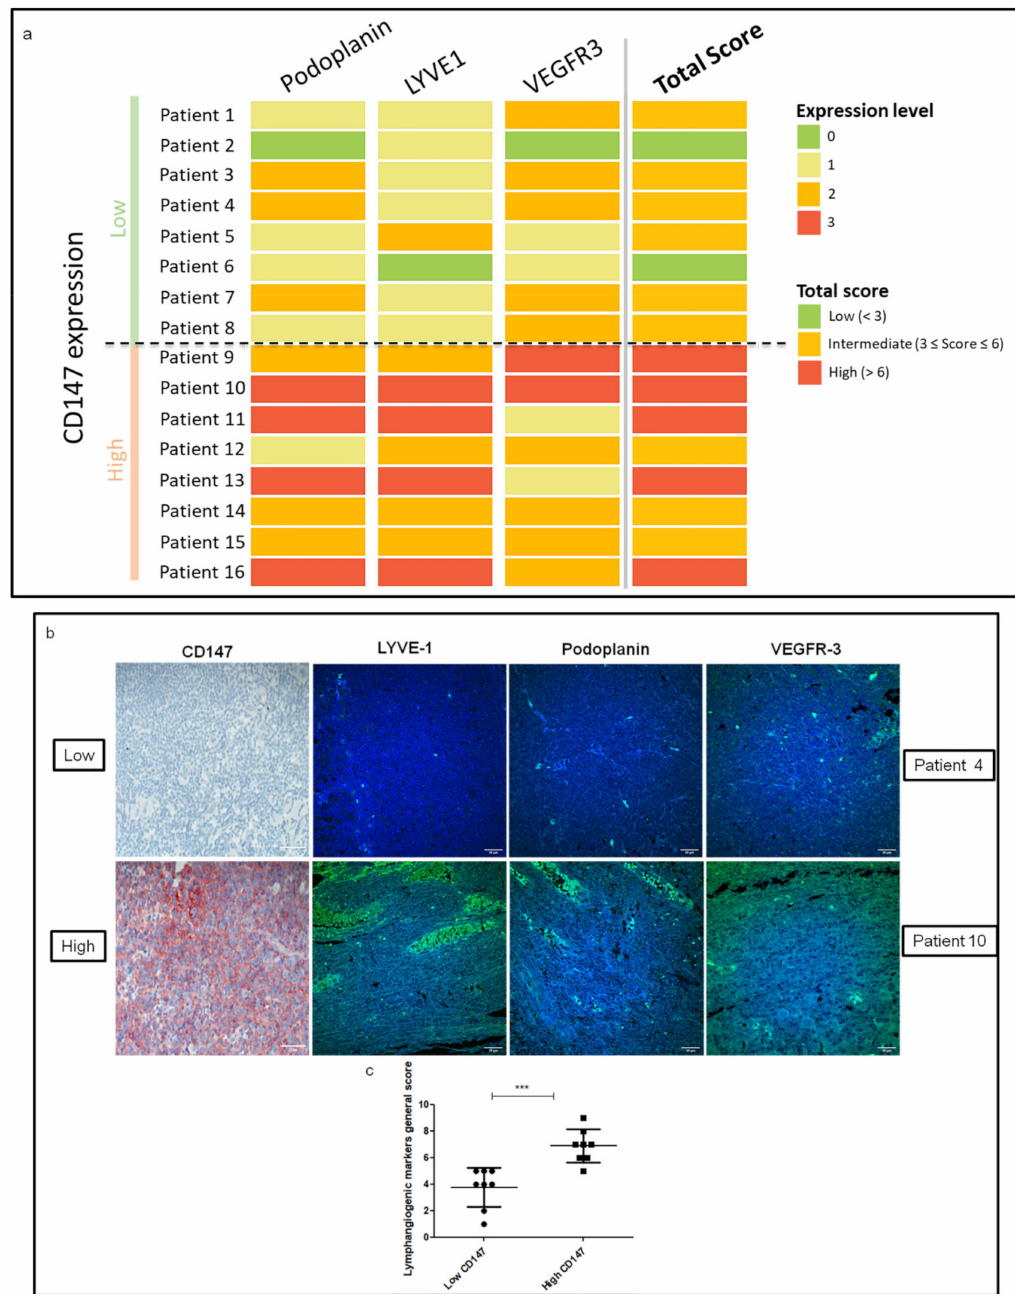
Figure 1. Lymphangiogenic markers’ expression in human melanoma lymph nodes expressing high or low CD147. ( a ) Level of expression of Podoplanin, LYVE-1, and VEGFR-3 according to CD147 expression in human melanoma lymph nodes. The intensity of staining was scored between 0 and 3 for each marker and CD147, and the total lymphangiogenic score was classified as high, intermediate, or low. ( b ) Representative images of CD147 immunohistochemistry staining and LYVE-1, Podoplanin, and VEGFR-3 immunofluorescence staining in melanoma lymph node samples of patient 4 (low CD147 expression) and patient 10 (high CD147 expression) (40 × magnification). Scale bar: 30 µ m. ( c ) Vertical scatter plot with mean of lymphangiogenic markers general scores of low vs. high CD147 expression in human melanoma lymph nodes. SD; *** p <